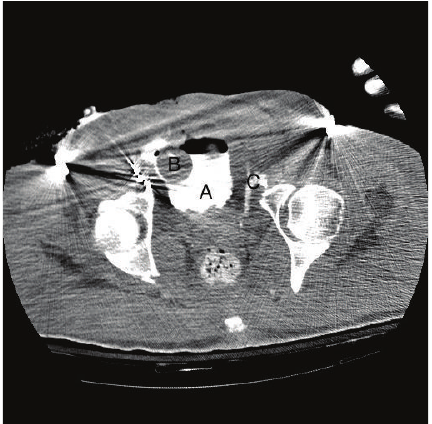
Figure 1: CT A/P demonstrating extent of injuries noted on presentation. A: bladder with contrast. B: balloon of suprapubic tube. C: contrast extravasation outside of the bladder.